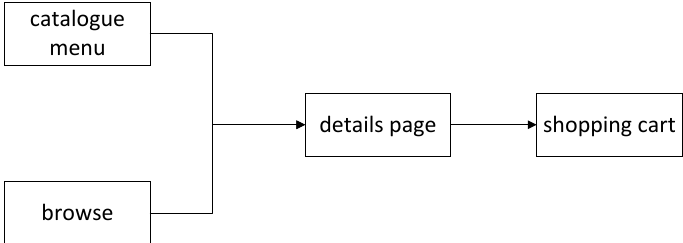
Figure 5. A typical process of Purchasing socks in